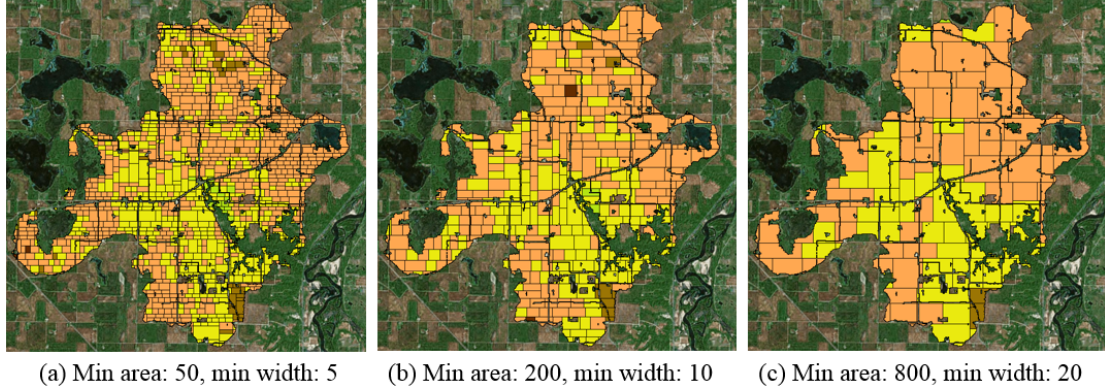
Figure 10. Fragmentation-free land allocation results with different spatial constraints. The minimum tile area and width gradually increase from ( a – c ). The total sediment of ( a ) is 1508 ton/year, ( b ) is 1597 ton/year and ( c ) is 1664